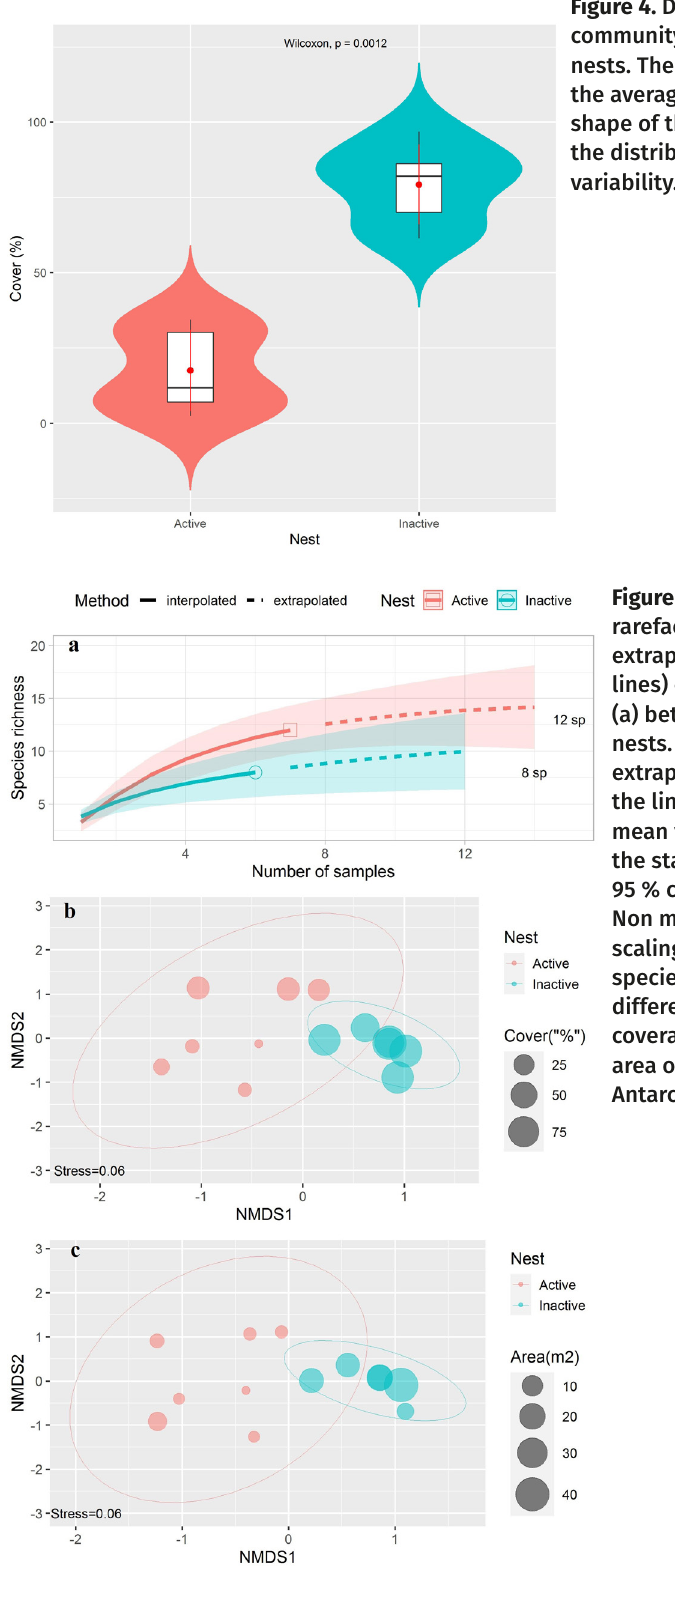
Figure 5. Sampled-based rarefaction (solid lines) and extrapolation curves (dashed lines) of species richness (a) between sampled nests. Rarefaction and extrapolation curves present the lines that represent the mean values and the bands the standard deviation with 95 % confidence intervals. Non metric multidimensional scaling (NMDS) based on species composition from different nests along a coverage gradient (b) and area of nests (c) in Maritime Antarctica.